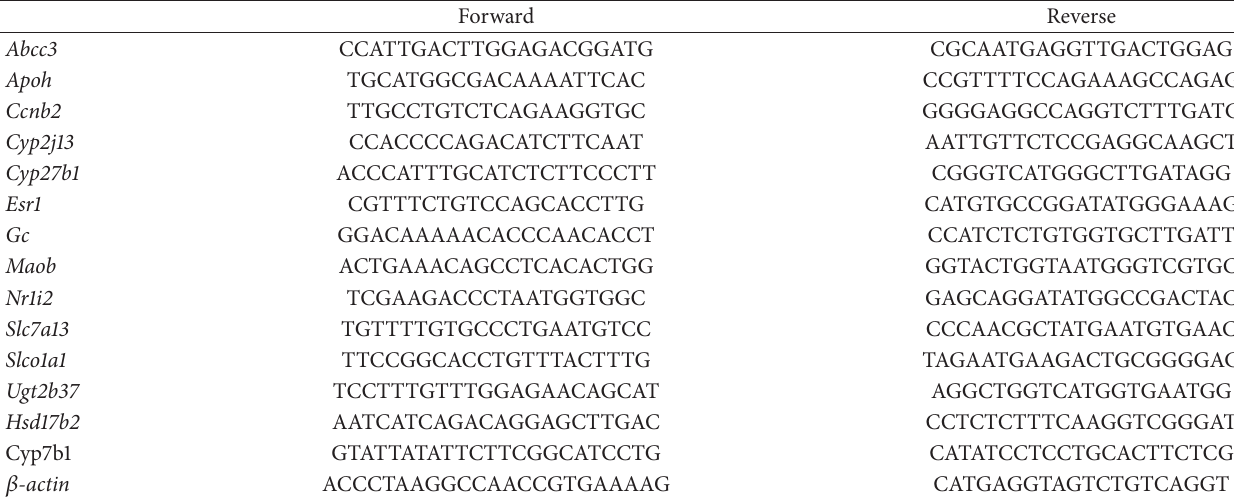
Table 1: Primers used in